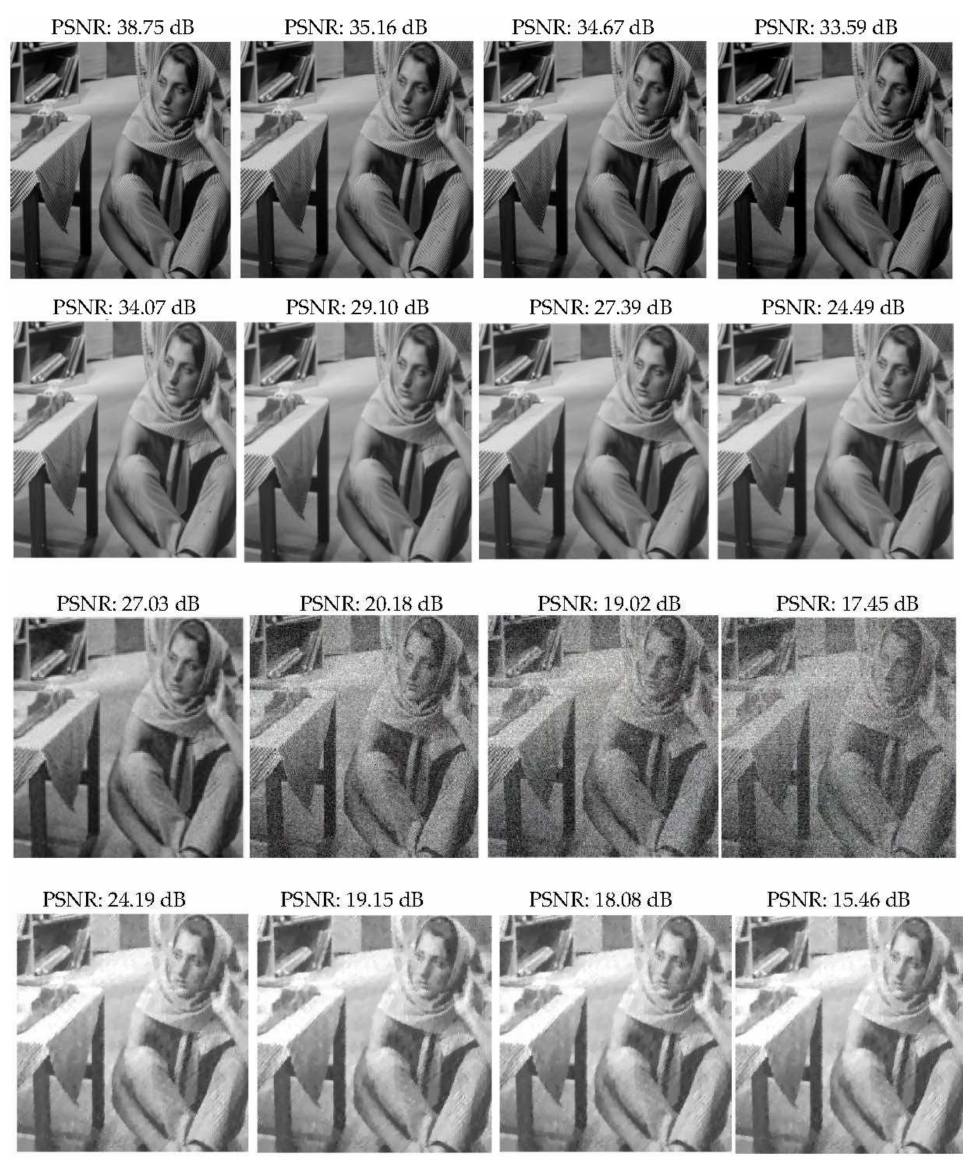
Figure 4. PSNR for different noise levels using the proposed DCSR, GSR algorithm, wavelet denoising and NESTA algorithm, arranged in rows 1, 2, 3 and 4, respectively. From left to right σ = 20, 50, 60 and 80,